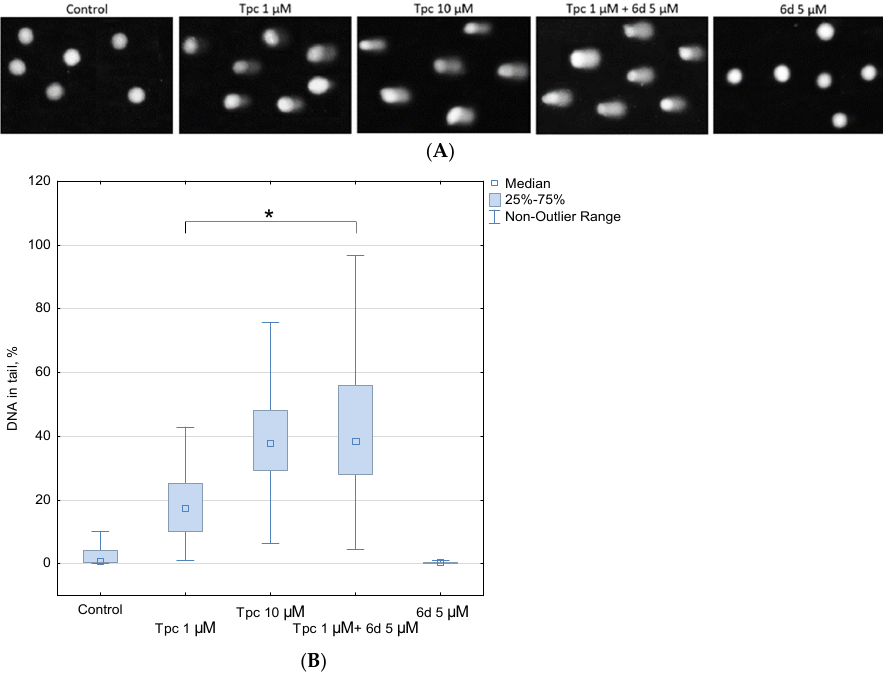
Figure 3. The use of compound 6d in a non-toxic concentration reduces the dose of topotecan required to produce a serious level of DNA damage by 10 times. The compound 6d leads to similar DNA